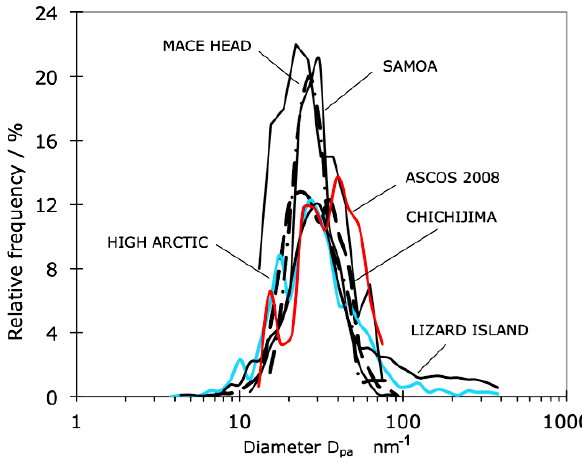
Figure 9. Number size distributions of airborne aggregate particles and their building blocks at different locations: Mace Head (53 ◦ N, 10 ◦ W), Lizard Island (14.6 ◦ S, 145.5 ◦ E), American Samoa (14 ◦ S, 172 ◦ W), Chichijima (27 ◦ N, 142 ◦ E), High Arctic (AOE-2001, be- tween 88.9 and 88.2 ◦ N; light blue line), and ASCOS 2008 (be- tween 87 ◦ N, 1 ◦ W and 87 ◦ N, 11 ◦ W; red line). All particles were assumed to be spherical in shape (from Bigg and Leck, 2008, mod-